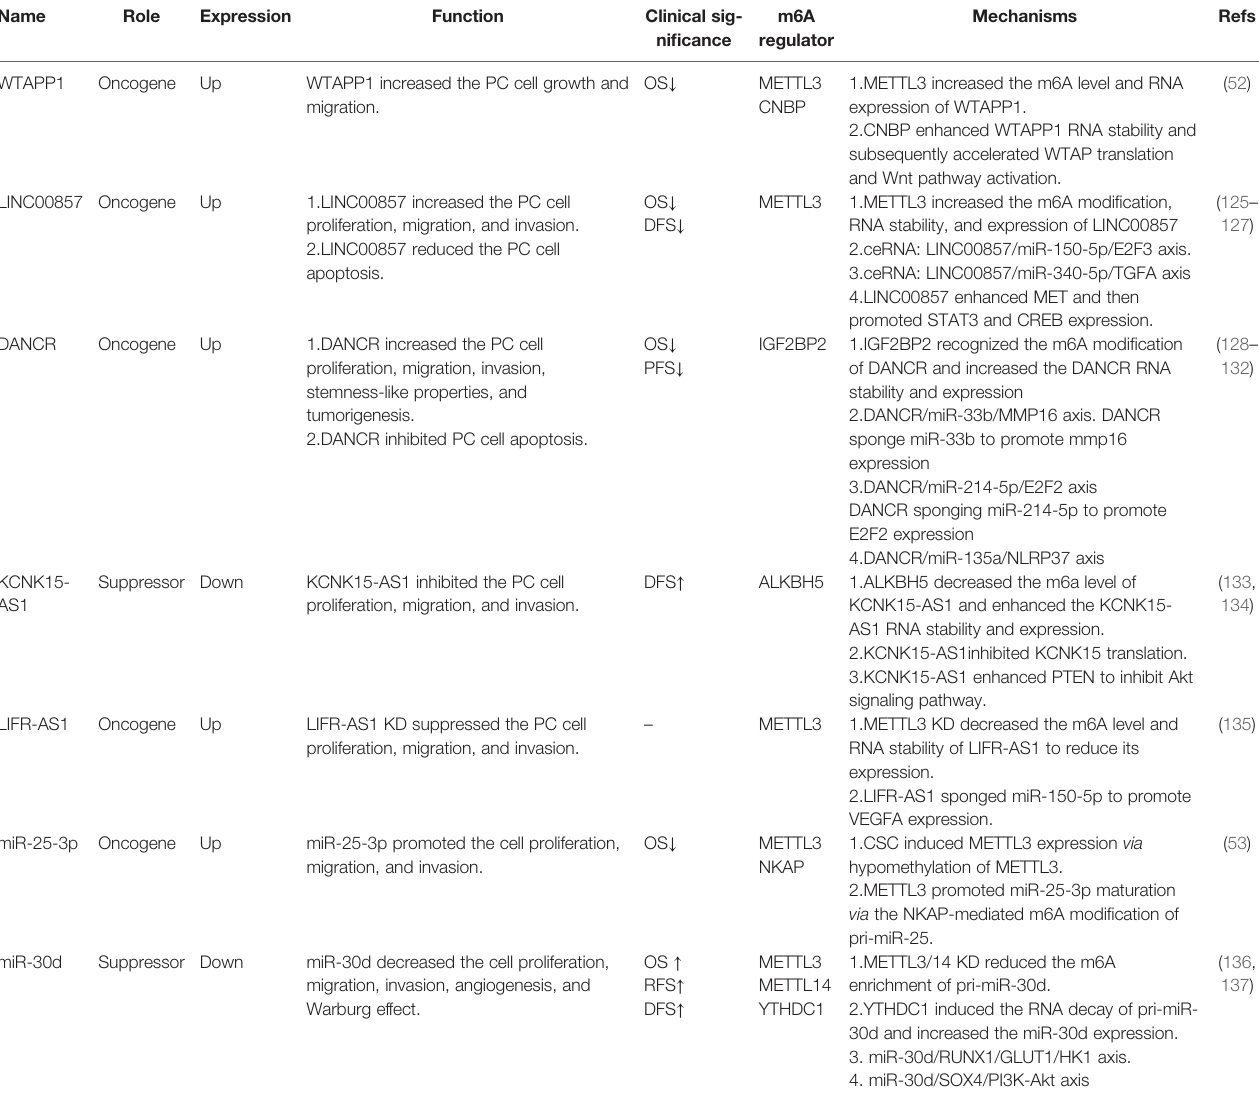
TABLE 2 | m6A modi fi cation of ncRNAs in pancreatic